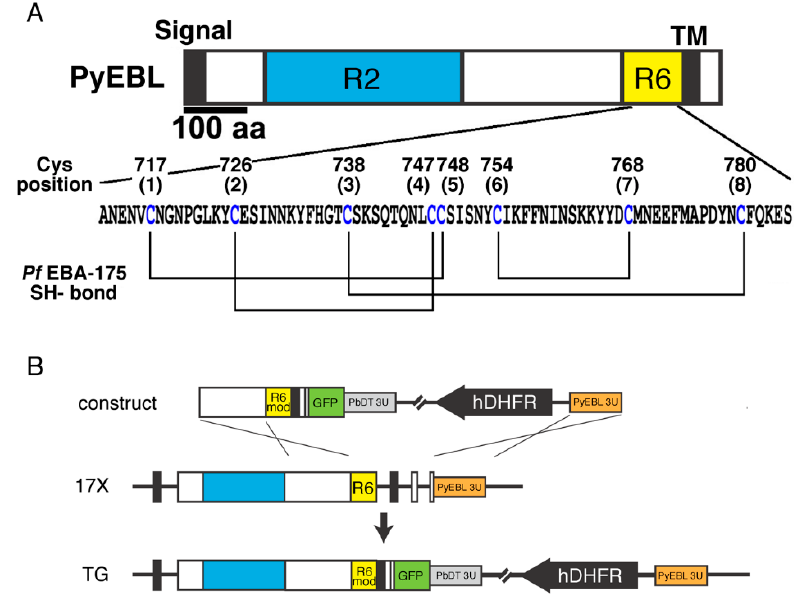
Figure 1. ( A ) Schematic structure of P. yoelii EBL (PyEBL). Signal, TM, R2, and R6 indicate the putative endoplasmic reticulum transporting signal, the transmembrane region, region 2, and region 6, respectively. The amino acid sequence of PyEBL in the 17X strain is shown below. Eight conserved Cys residues that form disulfide bonds based on the structure analysis of P. falciparum EBA-175 region 6 are indicated. ( B ) Schematic representation of the plasmid construct, pyebl gene locus in the 17X parental strain (17X), and transgenic lines (TG). The construct was inserted into the pyebl gene locus by double crossover recombination. In this scheme, “R6 mod” indicates the fragment of region 6 with a Cys substituted to Ala. hDHFR indicates a human dihydrofolate reductase expression cassette, which was used as a drug-resistant